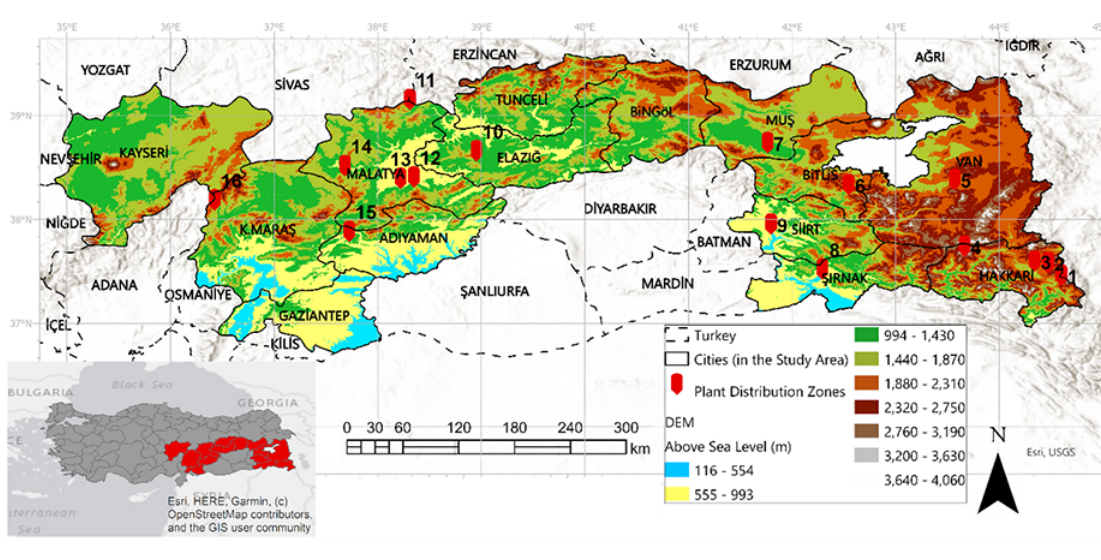
Figure 1 e locator map of the study area with hypsometric properties. e plant distribution zones indicated by Davis (1964–1985) were digitized for this study.